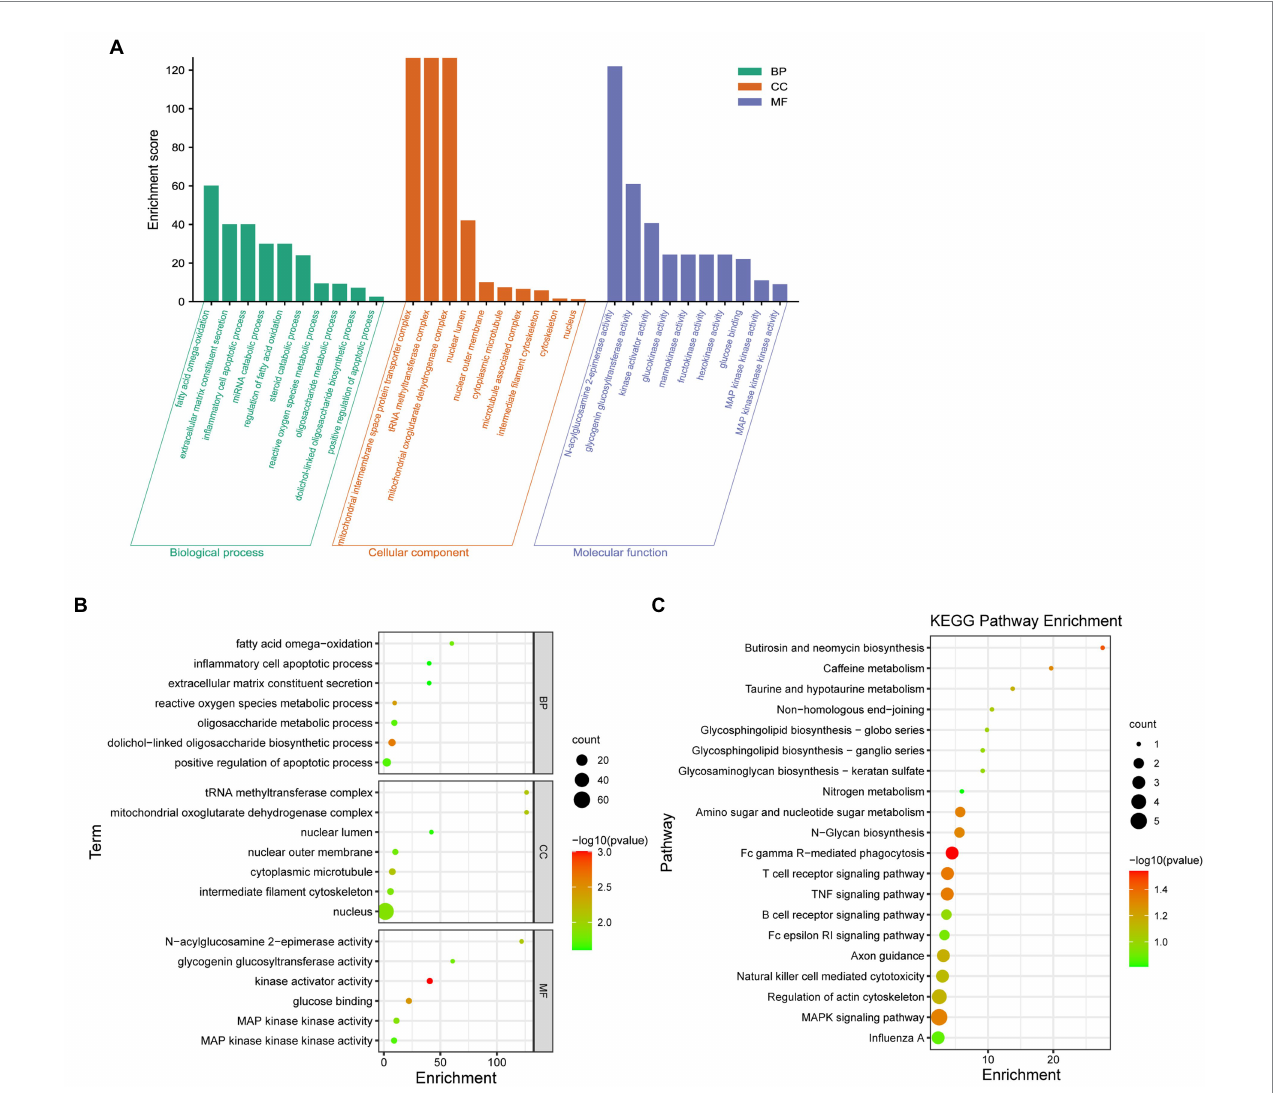
FIGURE 5 GO and KEGG pathway enrichment analysis was conducted with Resinacein S induced genes in human liver cells. (A) The categories in GO terms included cellular components (CC), molecular function (MF), and biological process (BP) were analyzed. (B) The top 20 significant GO terms of the overlapped DEGs were chosen based on the order of p value from small to large. (C) KEGG pathway enrichment analysis was performed with Resinacein S-induced genes. The top 20 significant KEGG pathways of the DEGs were chosen based on the order of p value from small to